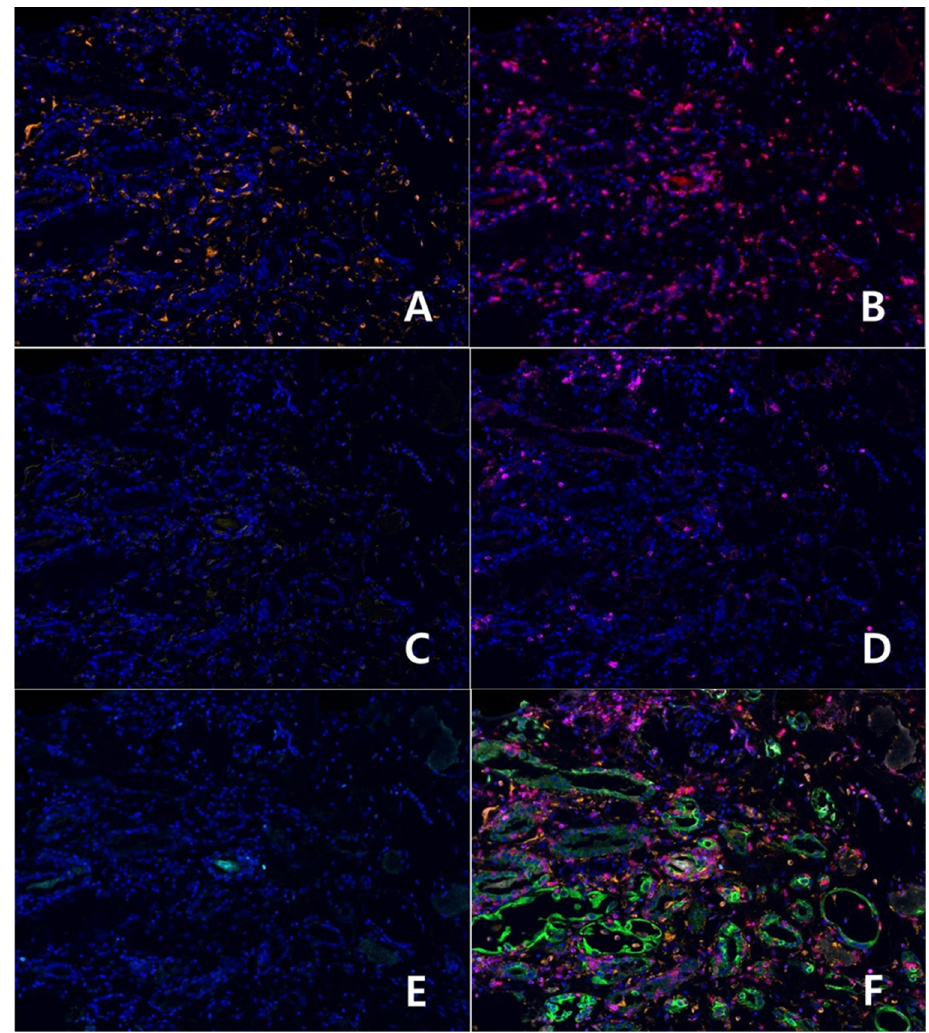
Figure 3. Multiplex immunofluorescent images show the individual antibody staining as follows (×200): ( A ) CD68+(Opal 620); ( B ) CD8+(Opal 690); ( C ) CD20+(Opal 570); ( D ) CD4+(Opal 540); ( E ) Foxp3+(Opal 650); ( F ) Antibody staining was merged with cytokeratin (CK, Opal 520) staining. Blue nuclear stain represents 4 ′ ,6-diamidino-2-phenylindole (DAPI). In acute TCMR cases ( n = 9), the cortical interstitium ( n = 16), area surrounding a large